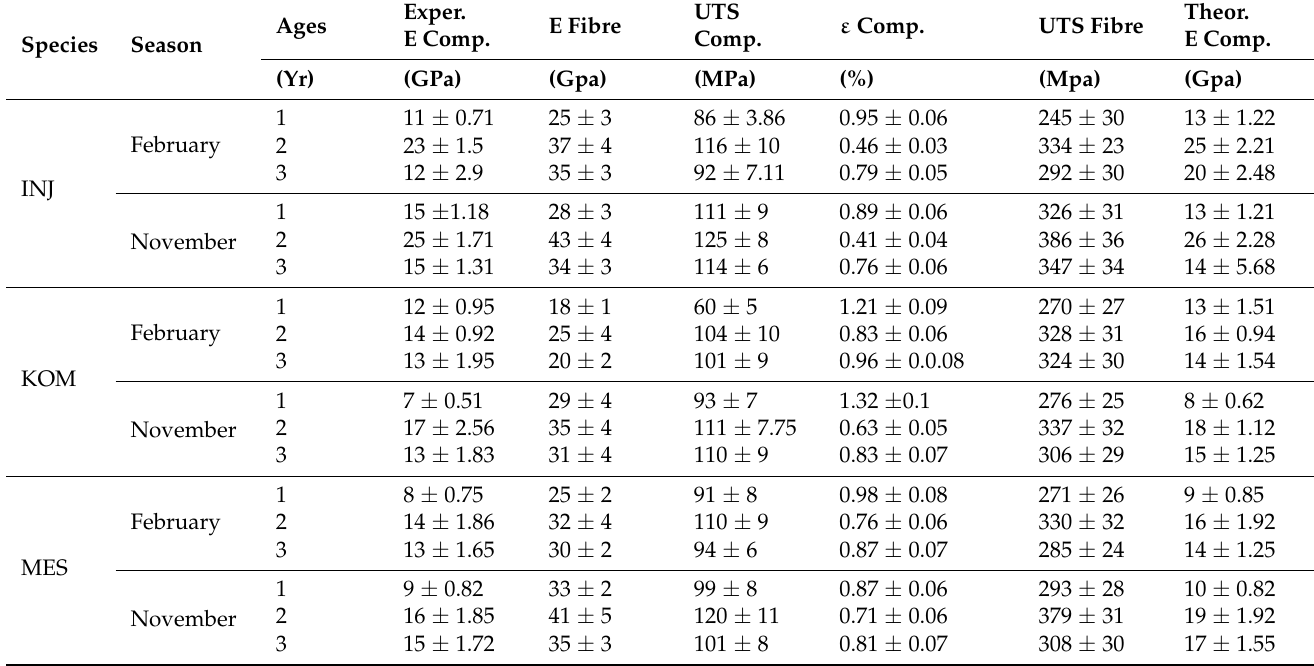
Table 2. Experimental results of tensile strength of bamboo fibre polypropylene